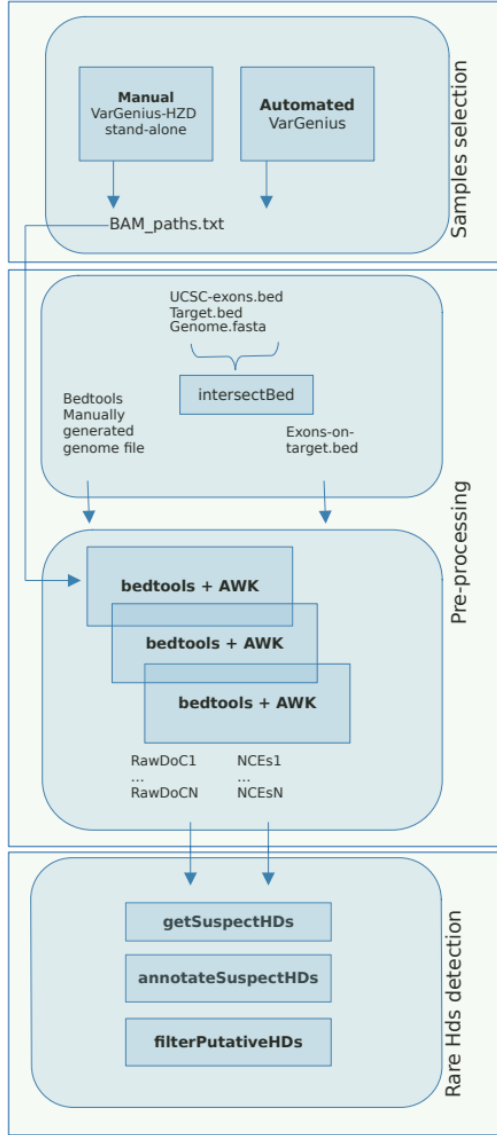
Figure 2. VarGenius ‐ HZD workflow. The workflow of our algorithm consists of three steps: 1. sample selection, which is automated in VarGenius software and manual in the stand ‐ alone version; 2. pre ‐ processing, which includes the generation of NCEs files and raw DoC information; 3. rare ‐ HD detection step, which involves the calculation of NCE frequencies, the detection of putative HDs, and the annotation of such regions for variant prioritization.